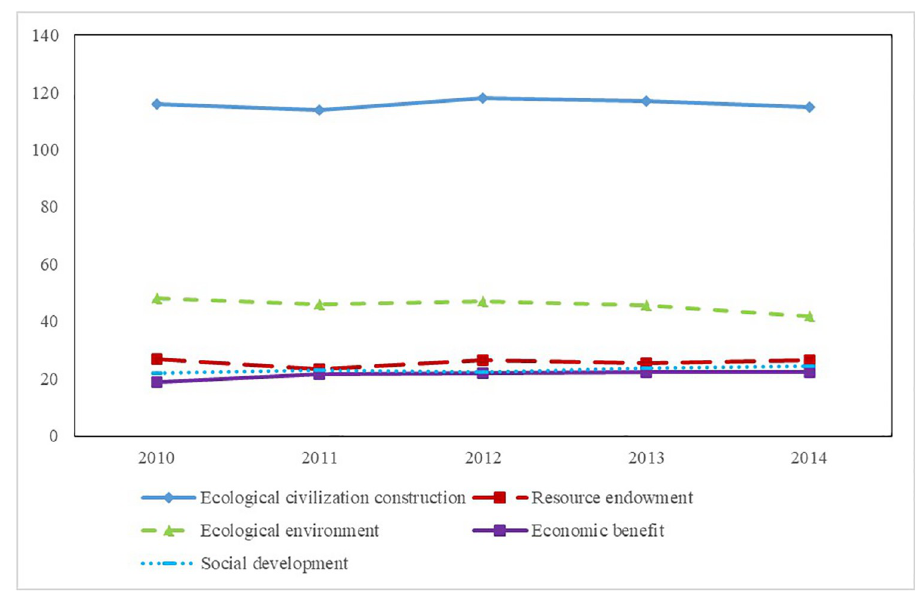
Fig 2. Evaluation result of the ecological civilization of Jiangxi Province. Source: Republished from Jiangxi Provincial Bureau of Statistics under a CC BY license, with permission from China Statistics Press, original copyright 2010 to 2014.